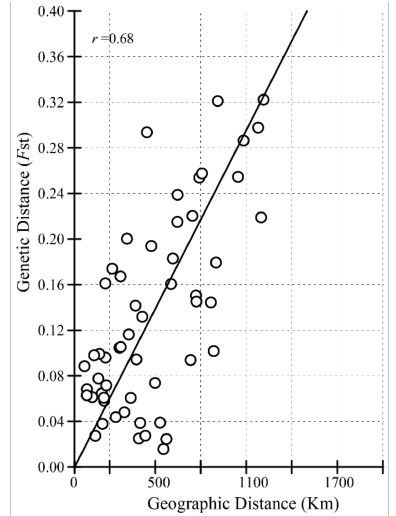
Figure 2. Relationship between geographic and genetic distances.